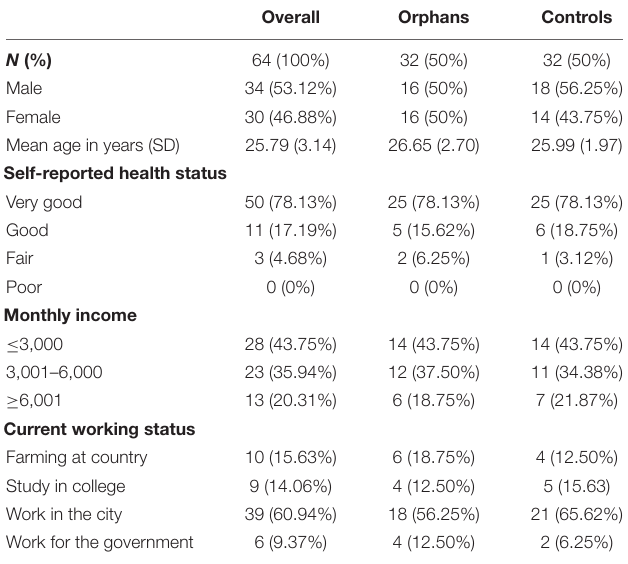
TABLE 1 | Individual characteristics of the